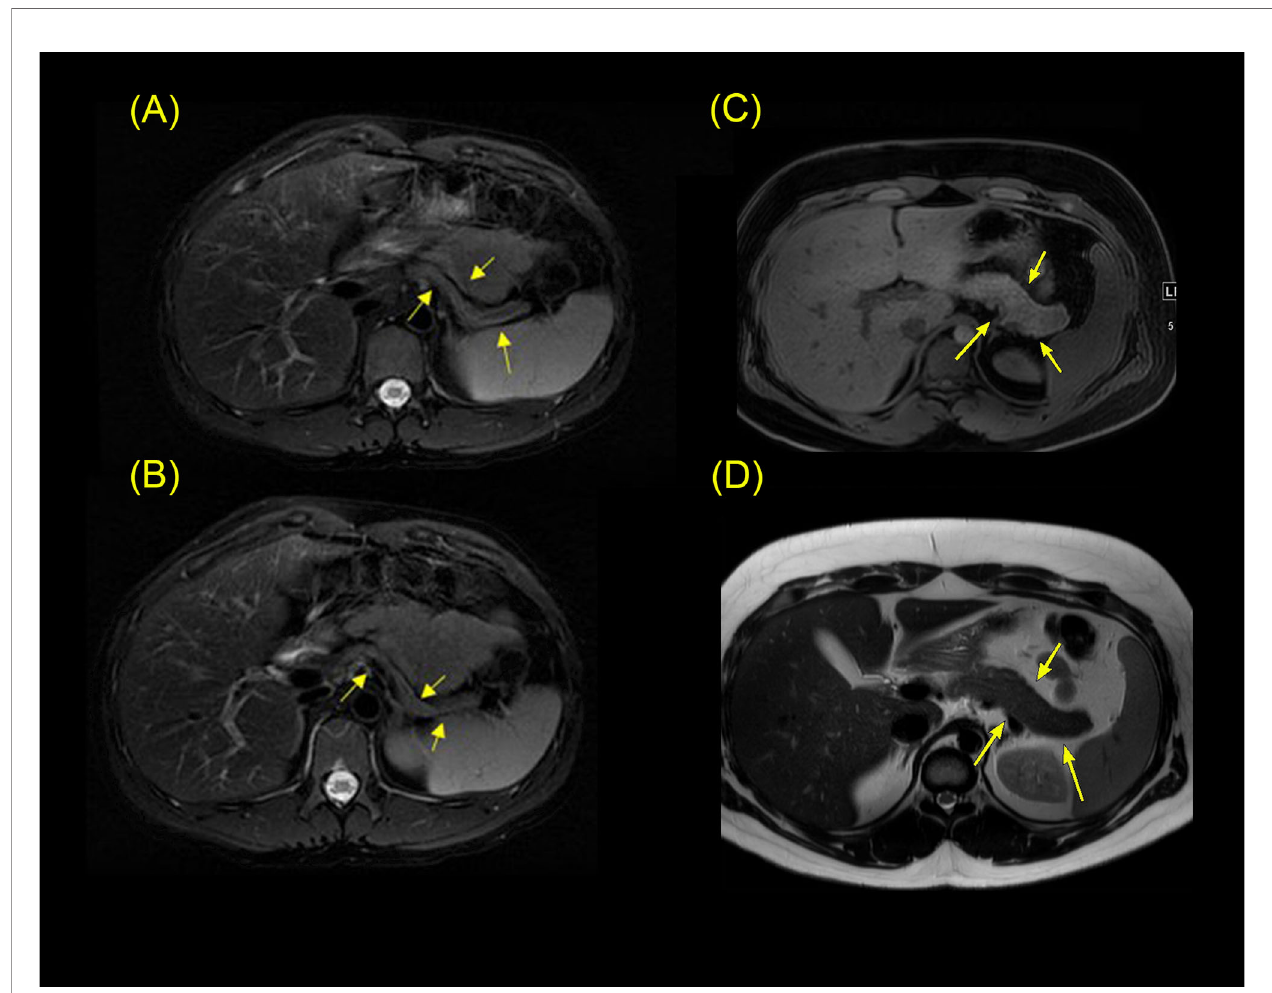
FIGURE 2 | Pancreatic MRI scan of the index patient (patient A) and control patient. The MRI scan in (A, B) showing a small atrophic pancreas of the index patient (patient A). Images clearly show global parenchymal atrophy of the pancreas. The pancreatic parenchyma appears thin with heterogeneous low T1 signals, indicating fi brosis. The MRI scan in (C, D) are axial T2 weighted MRI images of a control case, a 26-year-old male with type 1 DM. The images (C, D) show a normal volume of the